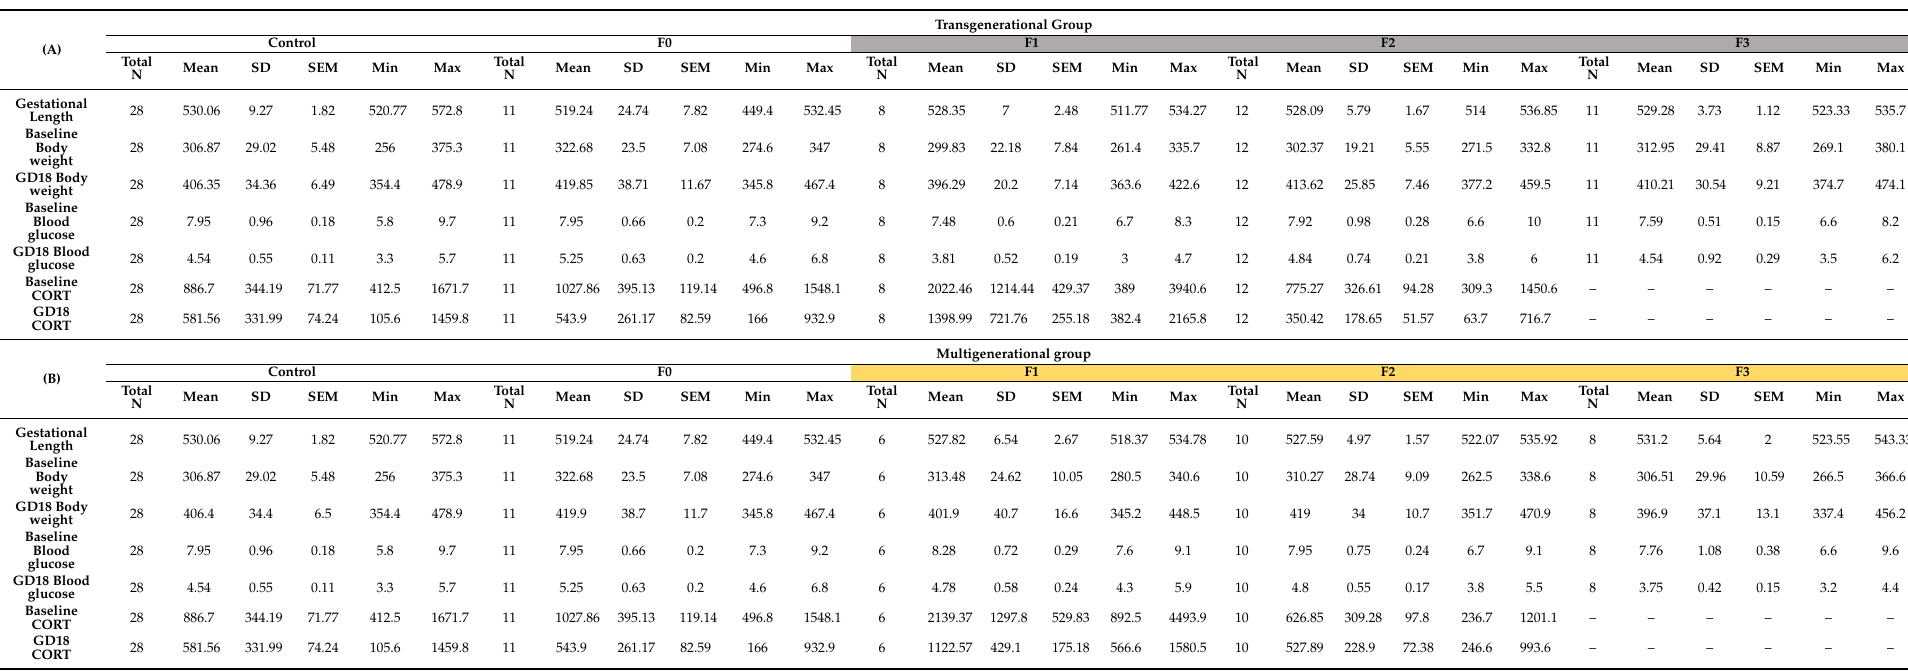
Table A4. Descriptive analysis for biological data. (A) transgenerational group; (B) multigenerational